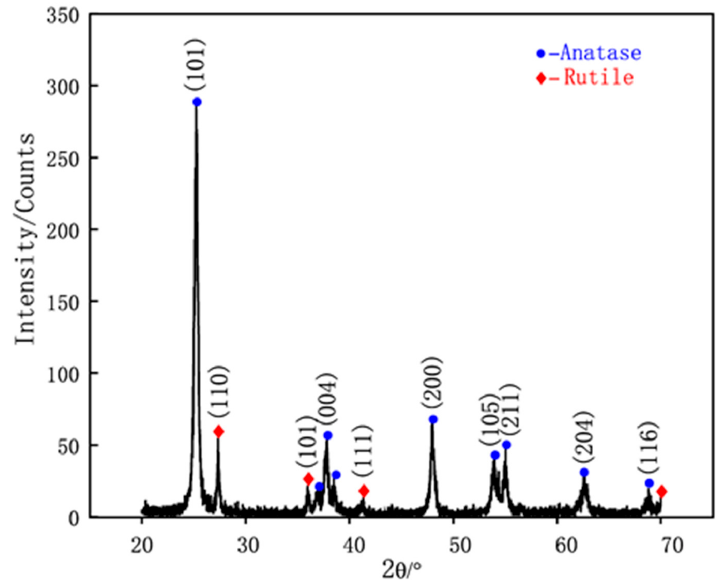
Figure 4. XRD pattern of TiO 2 NPs.